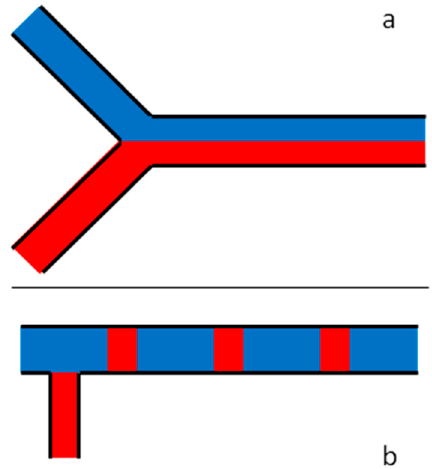
Figure 1. Schematic representation of a two-fluid flow with radial ( a ) or axial ( b ) heterogeneity before diffusion mixing operates.